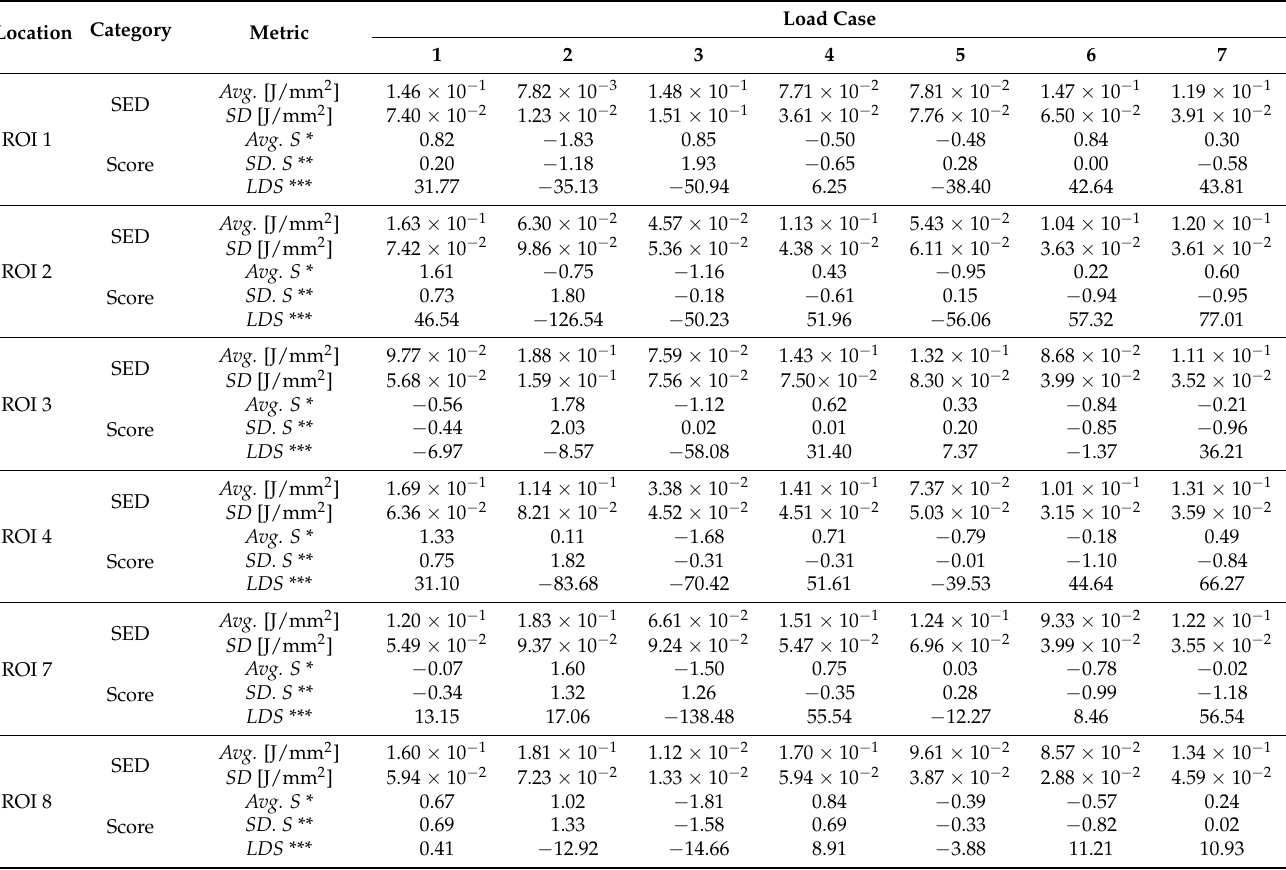
Table 3. Result of statistical analysis for strain energy density and scores for ROIs in the epiphysis for each load case.